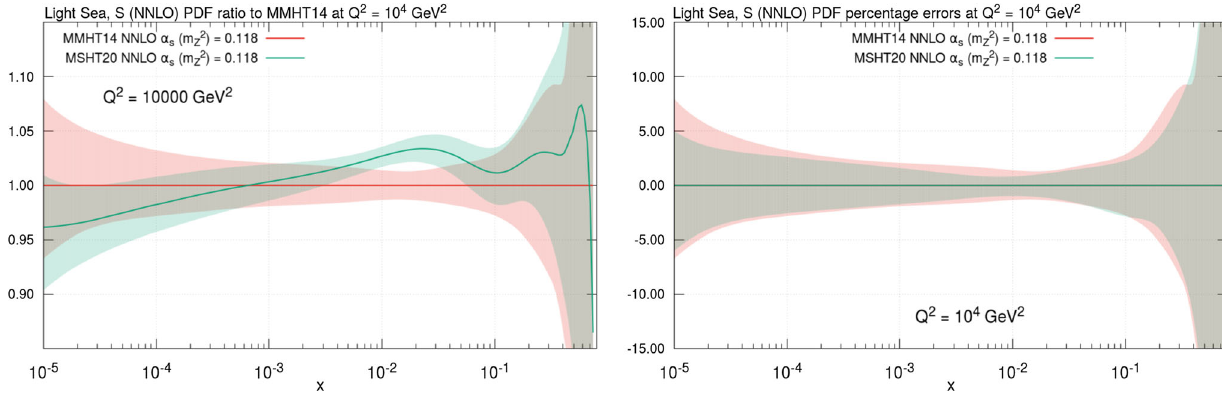
Fig. 19 Light sea (S) PDFs, for MSHT20 and MMHT14 at NNLO at Q 2 = 10 4 GeV 2 . (Left) ratio to MMHT14. (Right) percentage uncertainties